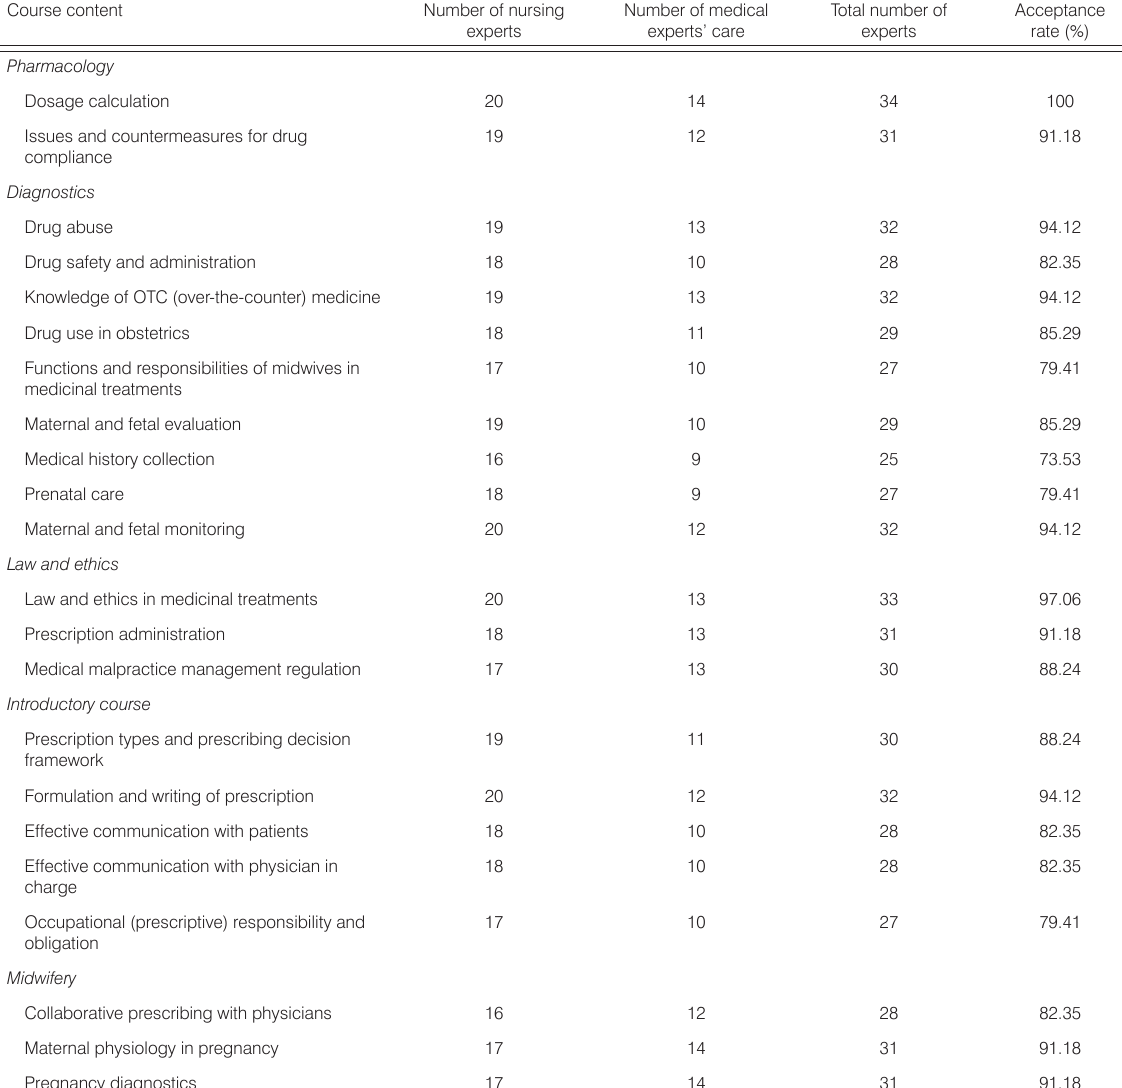
Table 9. The consensus on the training topics for prescriptive authority for midwives ( n = 34)